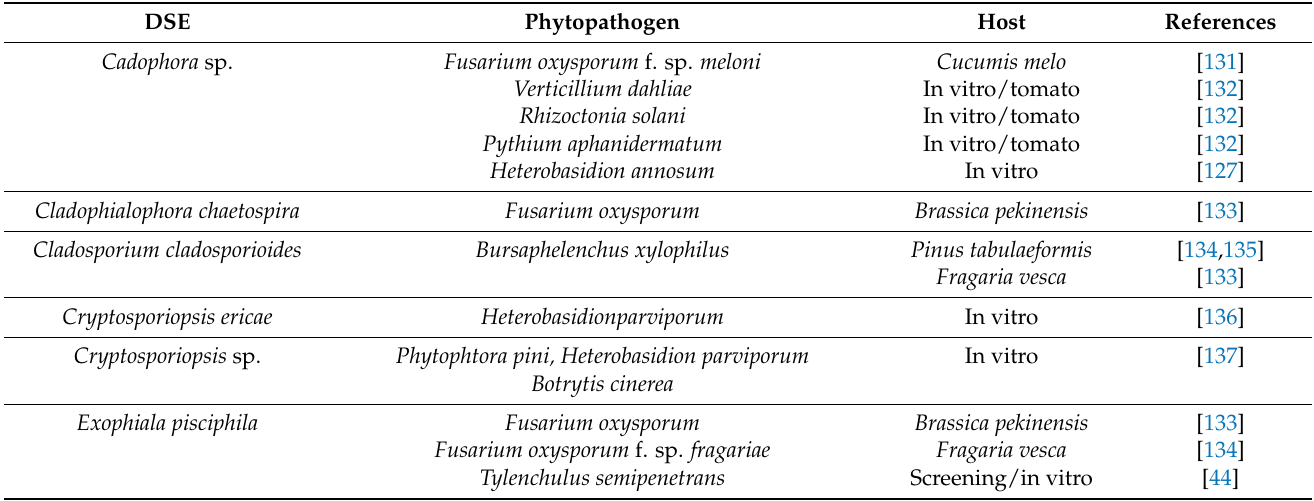
Table 1. In vitro and in vivo biological control tests carried out using